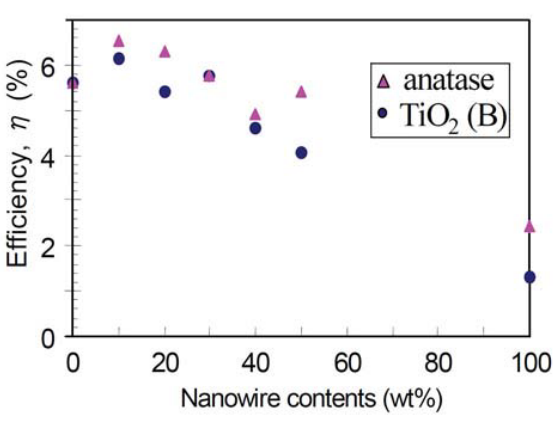
Fig. 10 Variation of conversion efficiency (%) vs TiO 2 (B) nanowire content.